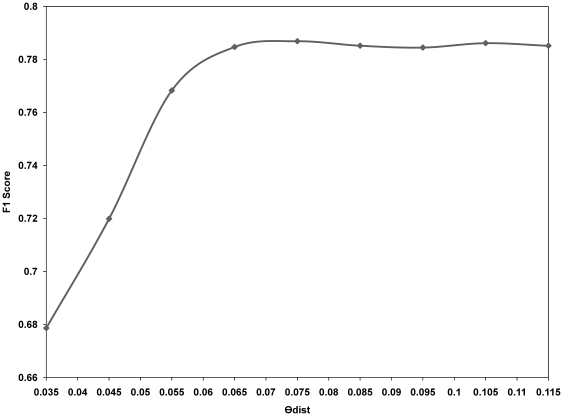
Maximum F1 score of MGVD for chromosome 22 according to various values of the two parameters, θdist and θCNVZ.